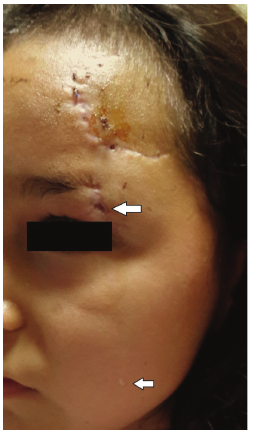
Figure 1: The photograph was captured immediately after irritation of the left eye with penlight. The big white arrow shows the orifice of the lacrimal gland fistula in the left superior orbital rim and small white arrow points out a teardrop, which was leaked from the